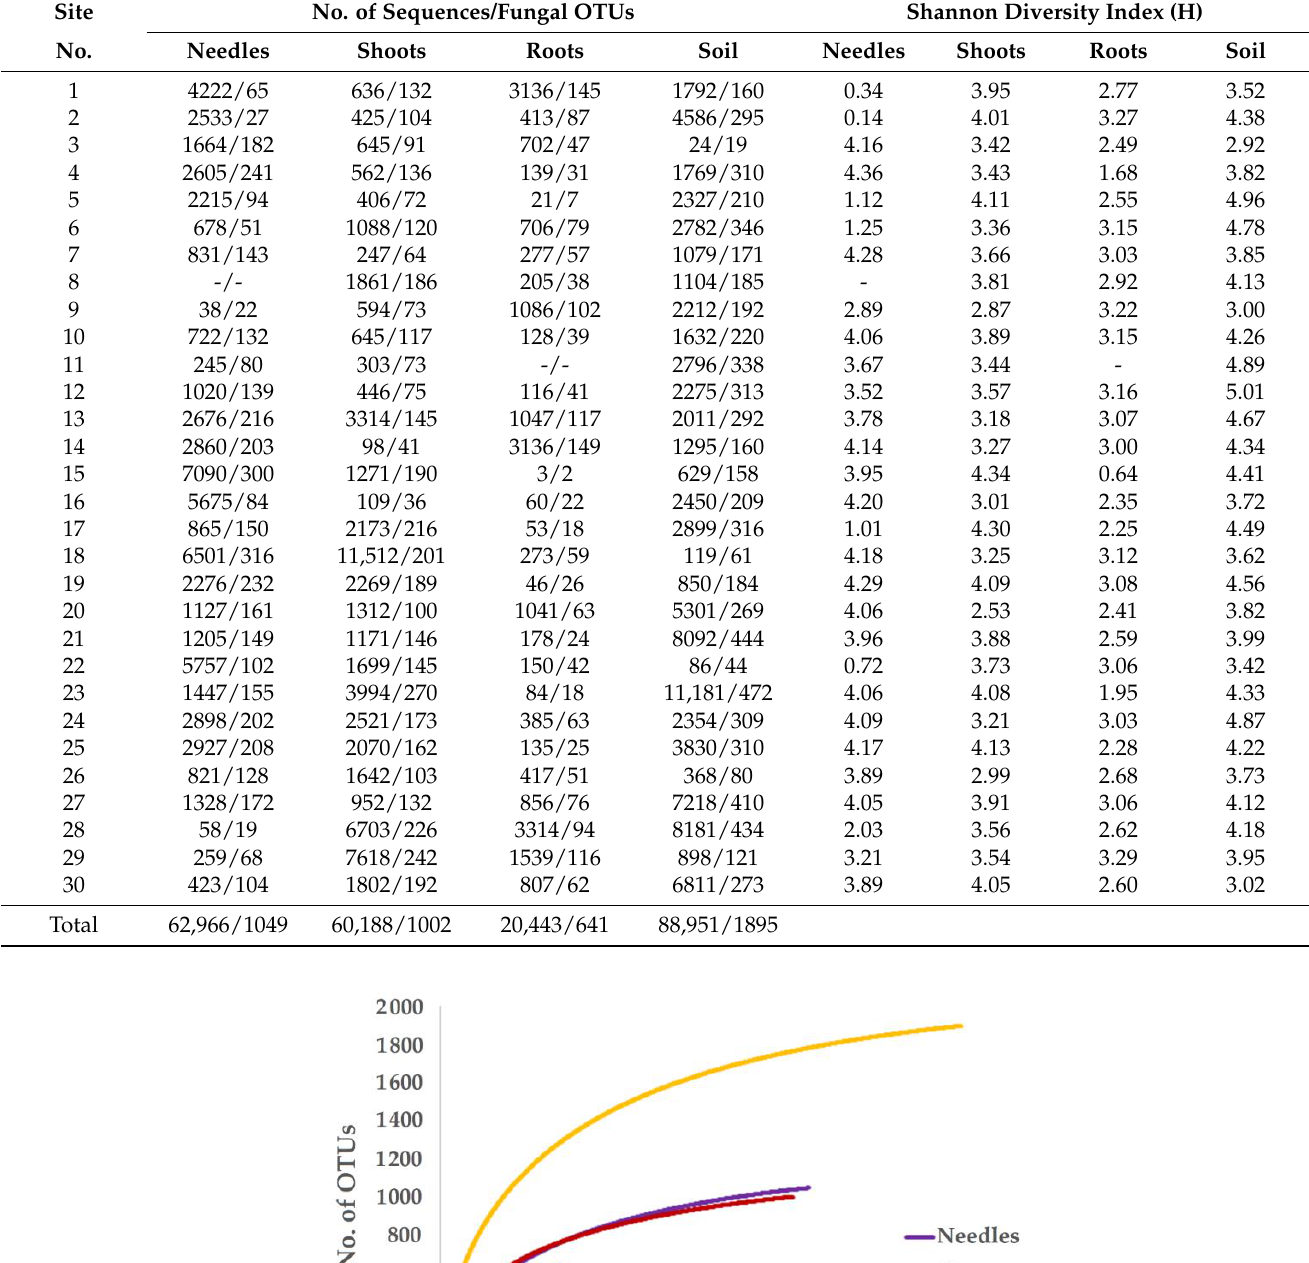
Table 2. Generated high-quality fungal sequences and detected diversity of fungal OTUs in different substrates from 30 Picea abies forest stands in Lithuania.